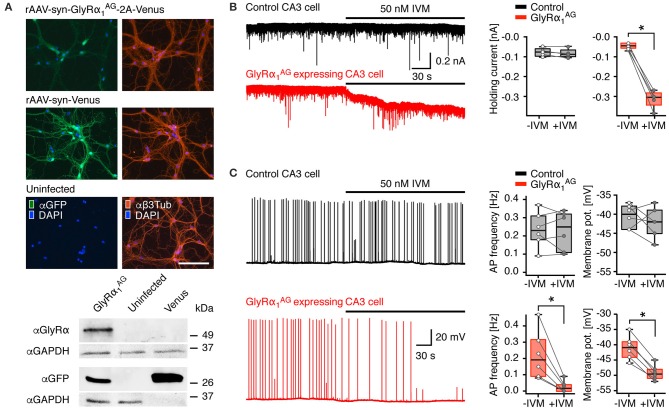
GlyRα1AG expression in transduced hippocampal primary neurons and acute slices of virus injected mice. (A) Top: Rat hippocampal primary neurons infected with rAAV-syn-GlyRα1AG-2A-Venus, rAAV-syn-Venus, and uninfected control; left column: Venus fluorescence amplified with an anti-GFP immunostain (αGFP, green); right column anti-Beta3Tubulin (αβ3Tub, red). The rAAV-syn-GlyRα1AG-2A-Venus infected cells show regular morphology and branching compared to rAAV-syn-Venus infected and uninfected cells; nuclei stained with DAPI (blue); scale bar 125 μm. Bottom: Cut outs of αGlyRα, αGFP and αGAPDH immunoblots of primary neuron cell extracts infected with rAAV-syn-GlyRα1AG-2A-Venus (GlyRα1AG), rAAV-syn-Venus (Venus), and uninfected cells. Please note that for αGFP blots the protein amount of rAAV-syn-Venus infected cell extracts loaded was 1 μg as compared to 10 μg for all other lanes shown. The full version of the immunoblot is presented in Supplementary Figure 1. (B) Patch clamp recordings from acute brain slices of mice injected with either rAAV-syn-GlyRα1AG-2A-Venus or rAAV-syn-Venus (control) into the hippocampus. IVM application failed to trigger any detectable current in CA3 pyramidal cells in slices from control animals (black trace), but activated a strong outward chloride current in Venus positive cells in slices from rAAV-syn-GlyRα1AG-2A-Venus injected animals (red trace); box plots (right) show cumulative data from n = 5 cells each (median, 25th/75th percentile); *p < 0.05 (C) IVM bath application had no effect on the AP frequency or the membrane potential of control neurons (representative black trace) but lead to a strong decrease in AP frequency and membrane potential in GlyRα1AG expressing CA3 pyramidal cells (representative red trace); box plots on the right summarize data from all recorded neurons (median, 25th/75th percentile); *p < 0.05. The open and filled circles represent AP frequency and membrane potential in individual experiments before and after IVM application (n = 6, except membrane potential of controls with n = 5), respectively.